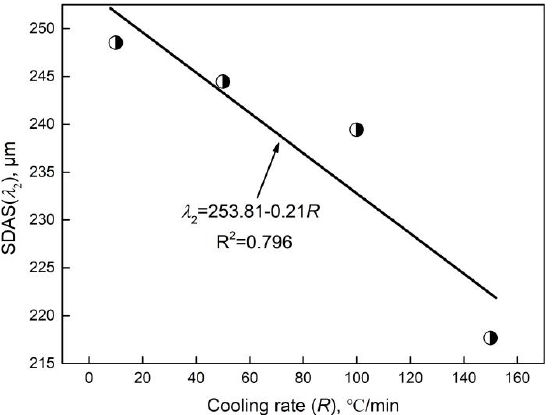
Figure 9. Effect of the cooling rate on SDAS at the stage of superheat elimination.